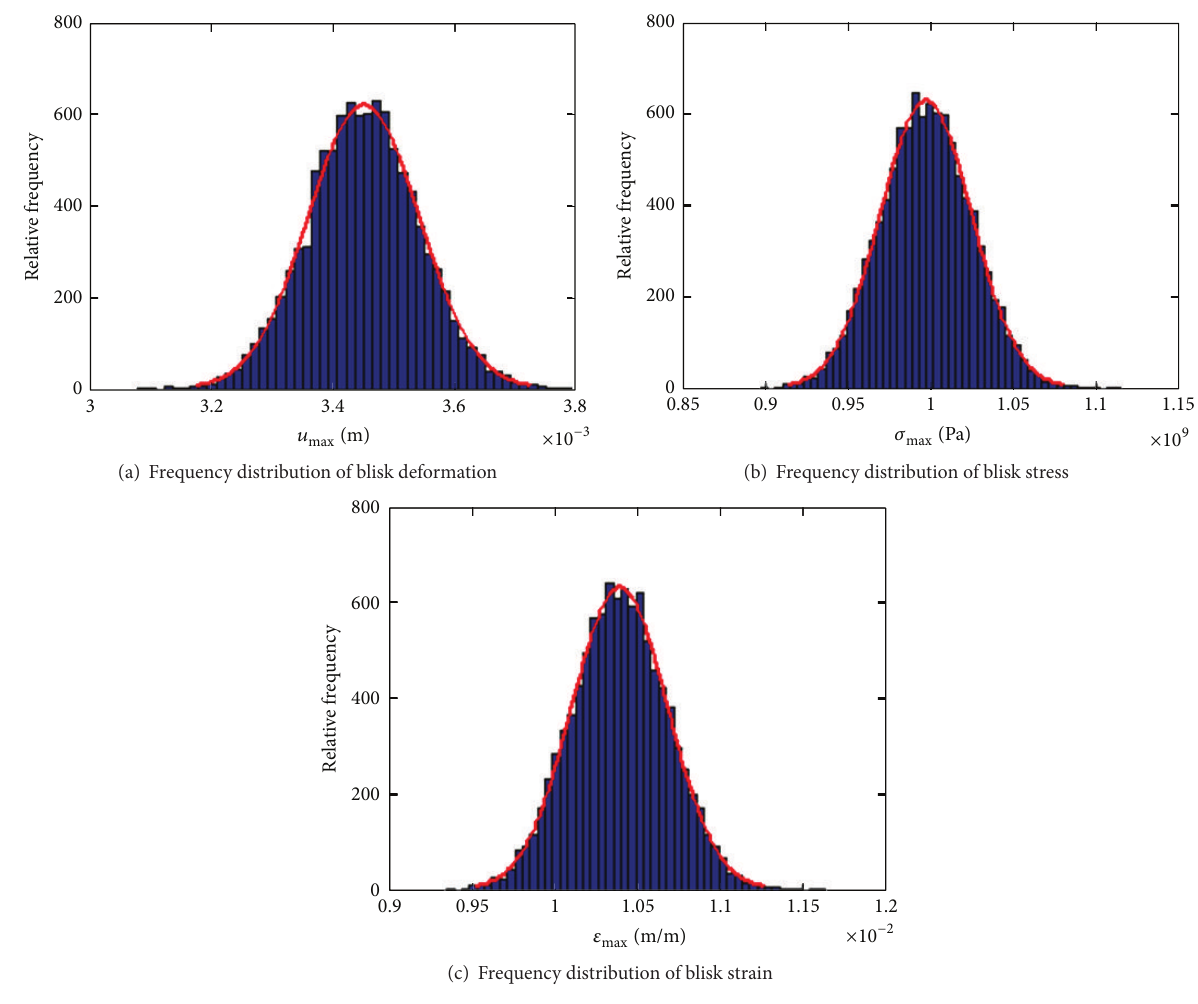
Figure 10: Frequency distribution of turbine